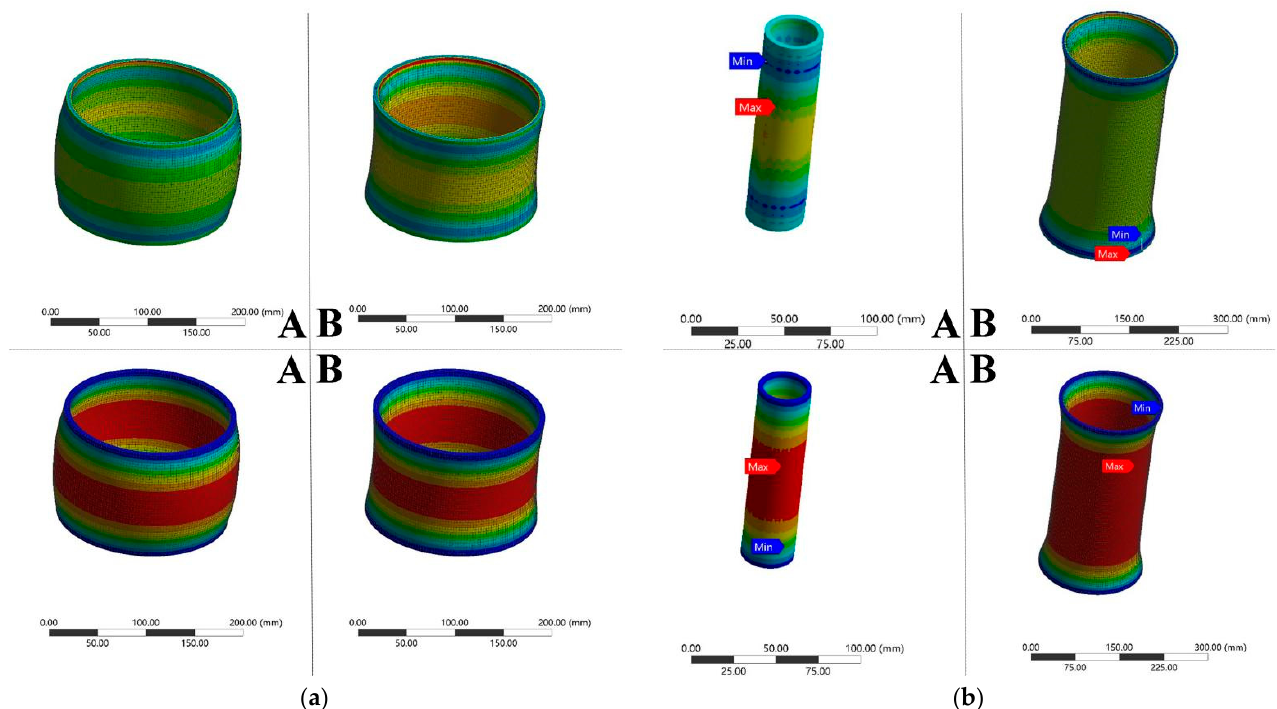
Figure 4. Comparison of casing stress and strain distribution under different conditions: ( a ) wellbore casing stress/strain distribution changes and ( b ) evaluate the variation in casing stress/strain distribution.